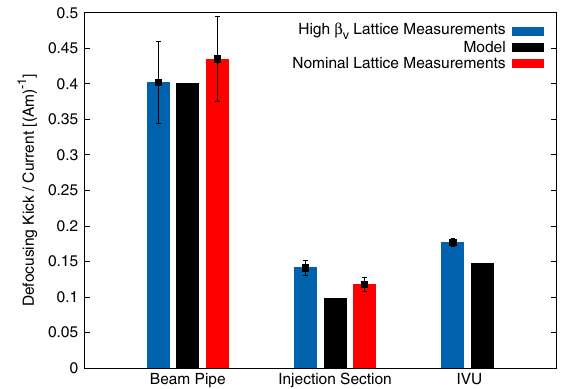
FIG. 11. In blue the defocusing kick strength per current unit obtained from the fit including the beam pipe, the injection section and the IVU located at the high vertical beta spot. Each measurement is obtained averaging over data sets containing 500 acquisitions each. The error bars represent the standard deviation of the estimated focusing kick due to the acquisition to acquis- ition fluctuations. In black is the predicted value from the impedance computation while red bars represent the defocusing kick obtained from the previous measurement (Fig. 8) where the nominal lattice was employed.